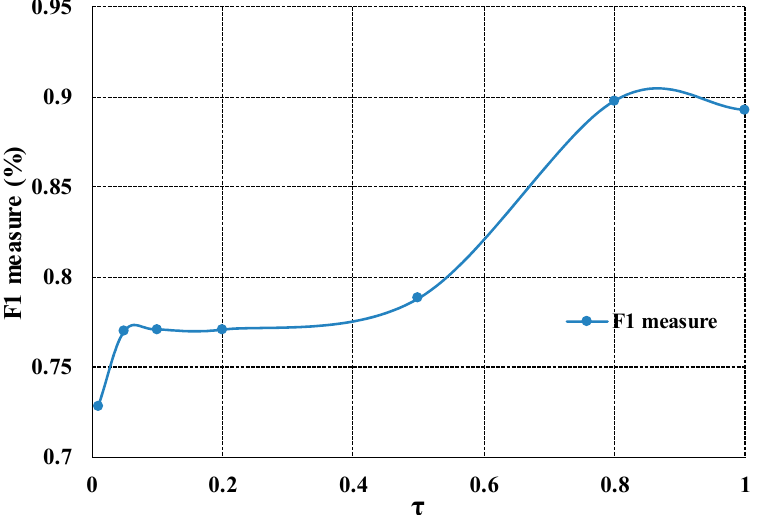
Figure 7. The observation of relationship between segmentation accuracy and the value of τ (the valve of K is constant “1”).